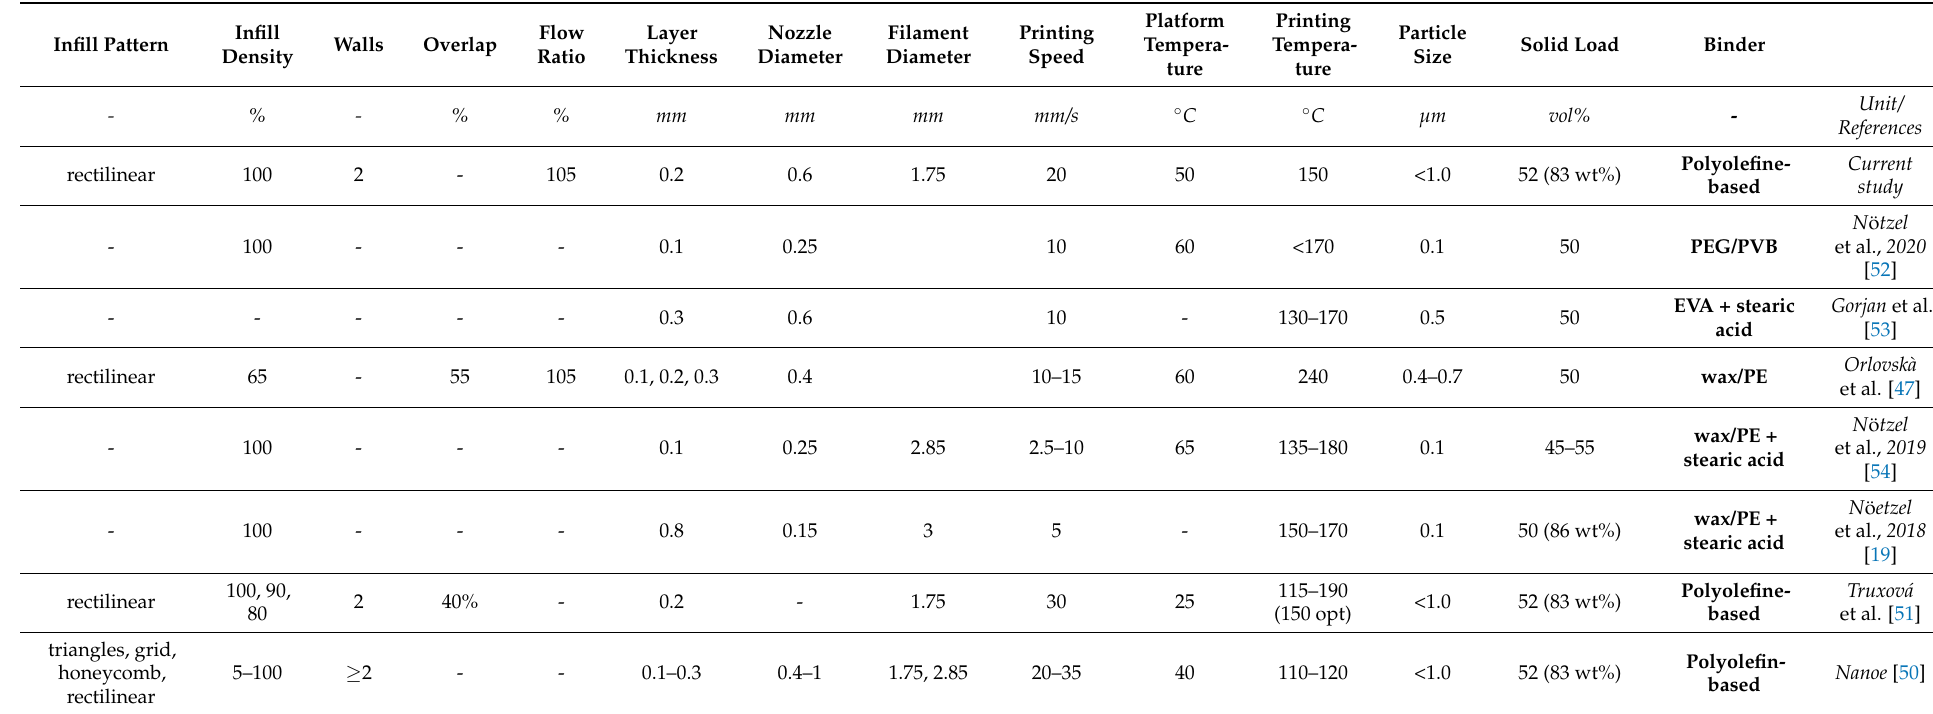
Table 1. Printing setting adopted in the current study in comparison with similar FFF